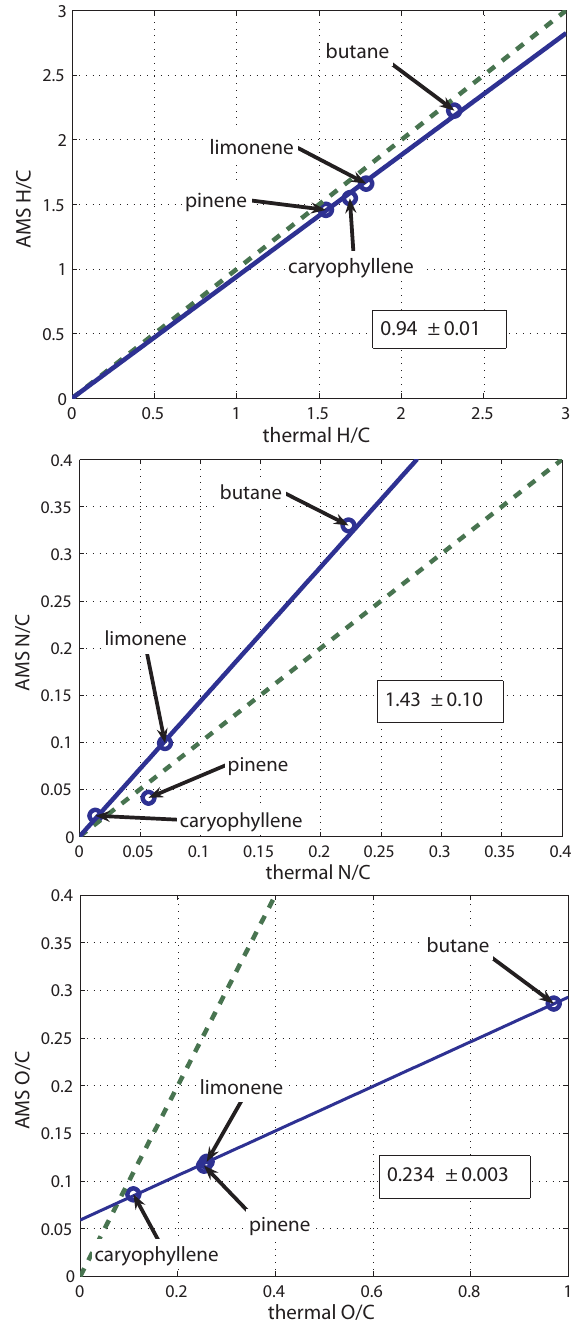
Fig. 3. Comparison of atomic ratios measured with the AMS, to atomic ratios measured by combustion elemen- tal analysis. Here we plot the elemental ratios calculated assuming equal response to CHN and O (corrections to elemental analysis recommended by Aiken et al. (2008) have not been applied to the data). Green dashed line is a 1:1, and solid blue is a linear fit to the data with 𝑦 -intercept forced to zero.